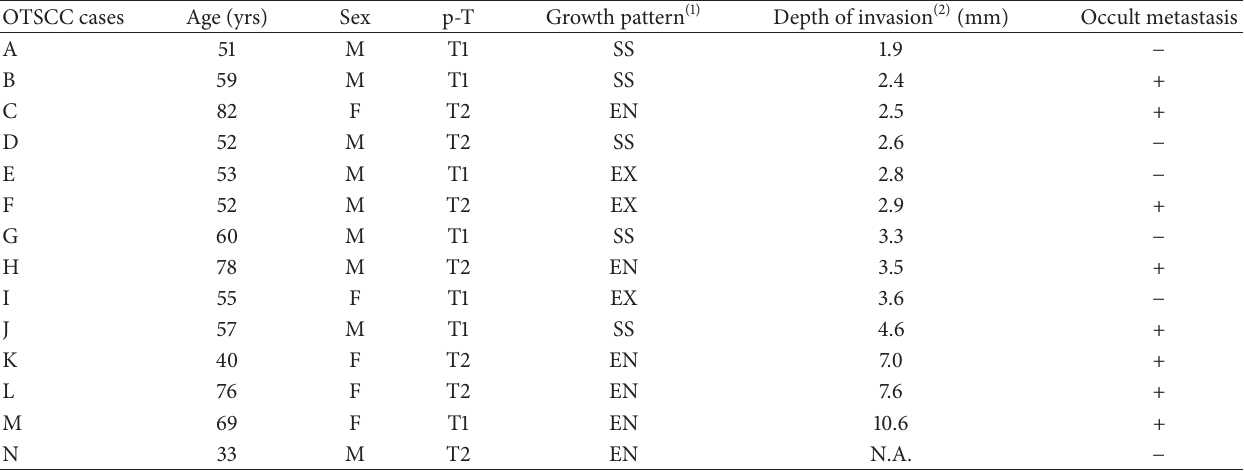
Table 1: Clinicopathological features of 14 patients with